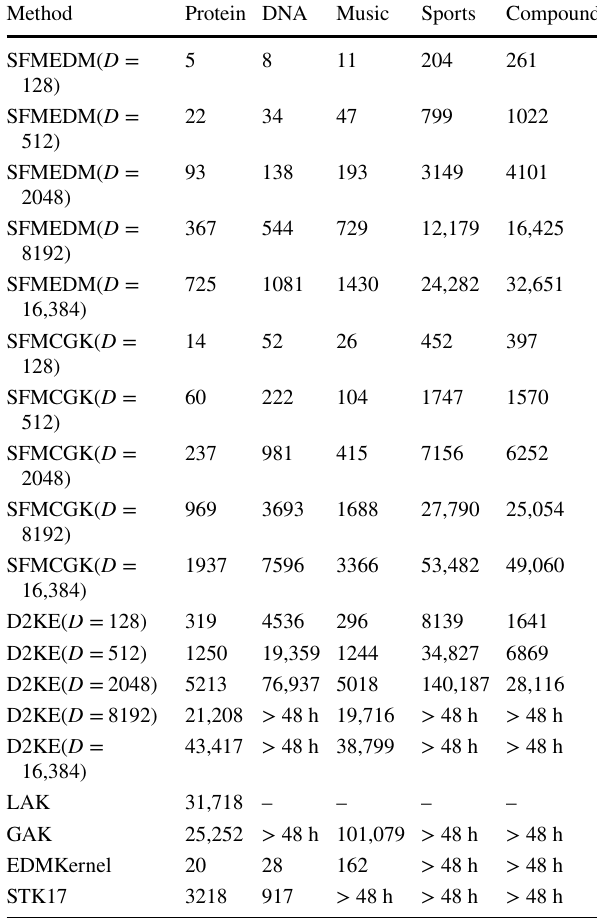
Table 6 Execution time in seconds for building feature vectors and computing kernel matrices in addition to training linear/nonlinear SVM for each method Method